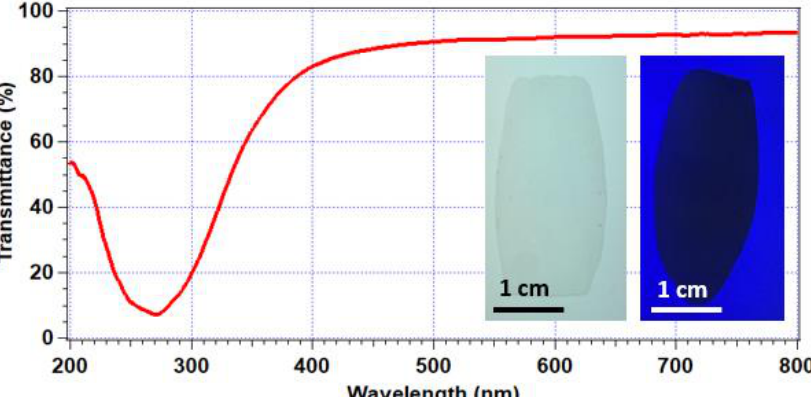
Figure 2. Normal incidence transmission of a well-ordered polymer opal with a photonic bandgap at 270 nm; inset L: polymer opal coated onto a white-light box, demonstrating high transparency; R: polymer opal coated onto paper and illuminated by UV LED, whereby the photonic bandgap prevented fluorescent excitation, resulting in a shadow.